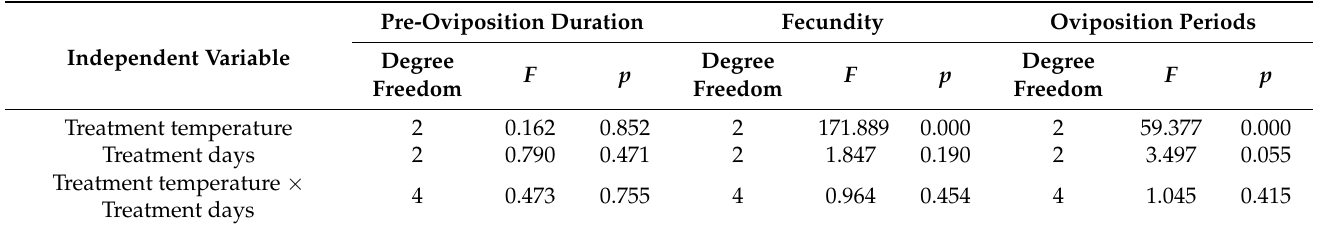
Table 3. Results of general linear model (GLM) for effects of treatment temperature, treatment days and their interaction on the reproduction of CPBs.